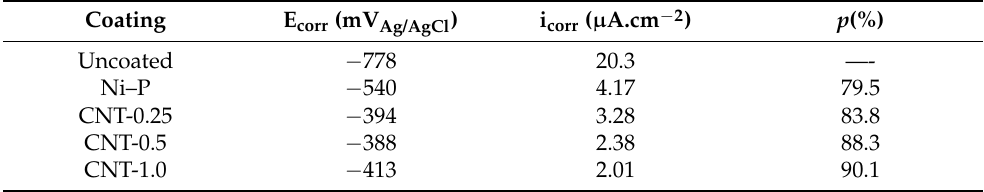
Figure 6. Potentiodynamic polarization curves of the Ni–P and Ni–P/MWCNT coatings after 1 h of immersion in 3.5 wt.% NaCl solution at room temperature. Table 3. Corrosion parameters of the uncoated substrate, Ni–P and Ni–P/MWCNT coatings.